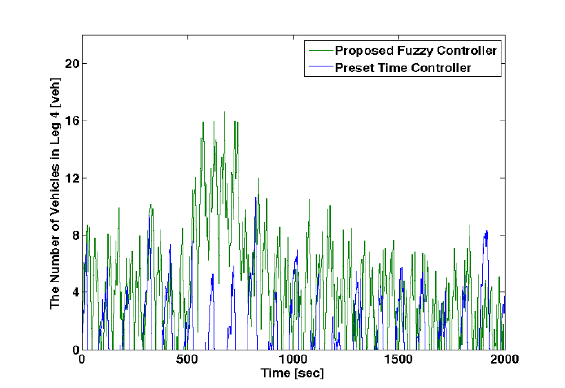
Figure 16. The number of vehicles in